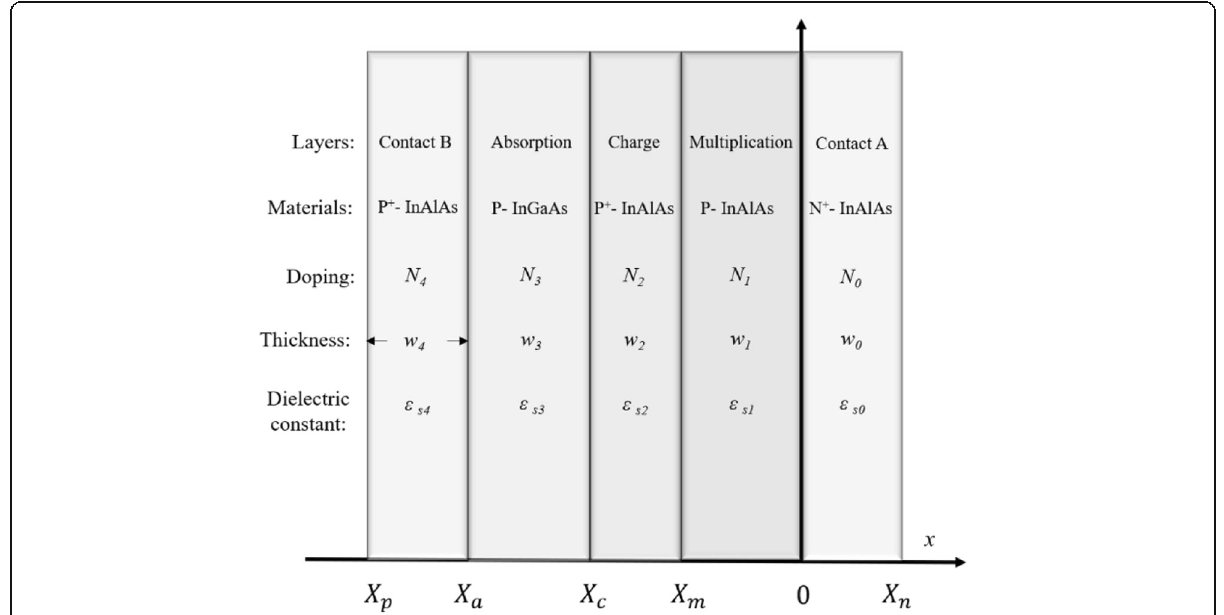
Fig. 1 The simplified mathematical coordinate system of SACM InGaAs/InAlAs APD. Presents the simplified structures of an APD that is used to build a theoretical model. The simplified mathematical coordinate system of the APD that includes basic structure parameters (materials, thickness, doping, and dielectric